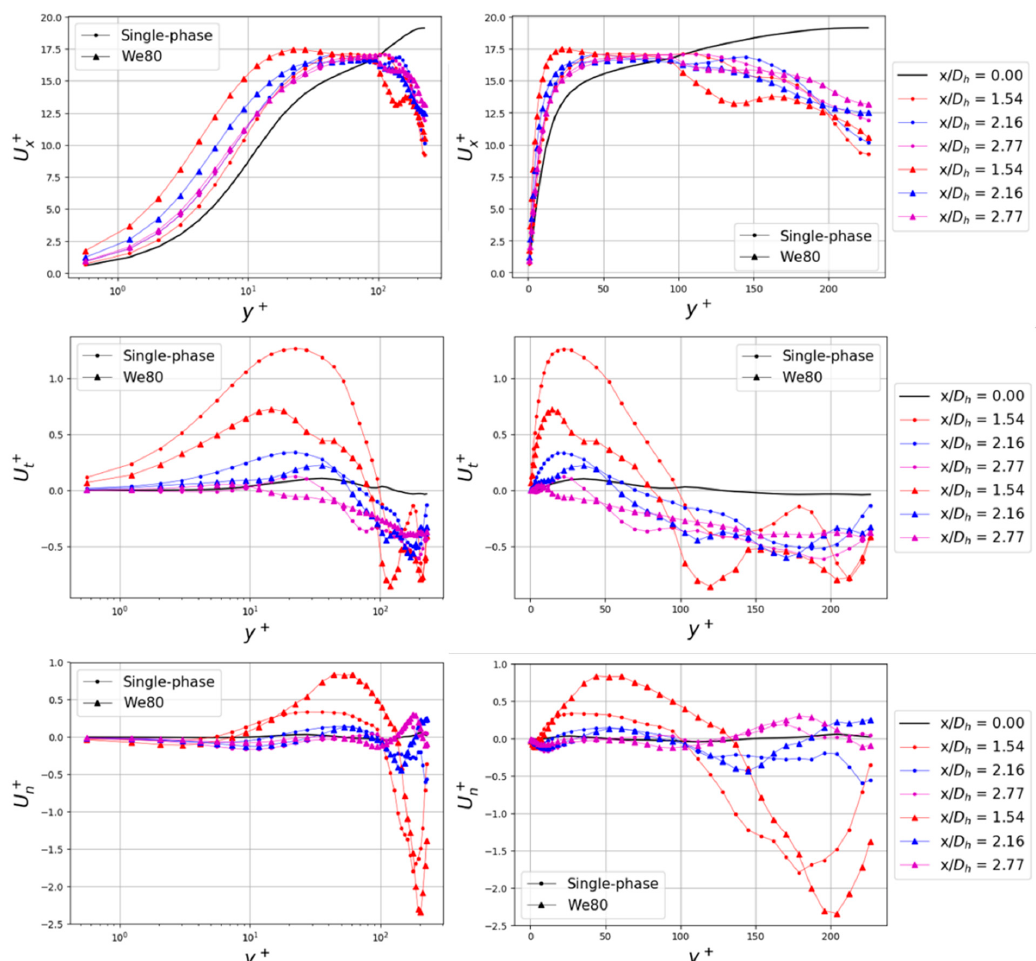
Figure 6. Comparison of downstream normalized mean velocity components for the We80 case with the single-phase simulation. Inlet profile (similar for both cases) is shown in solid black. Profile at three downstream planes are shown for each case (lateral coordinates rotated to 𝑡 − 𝑛 system).